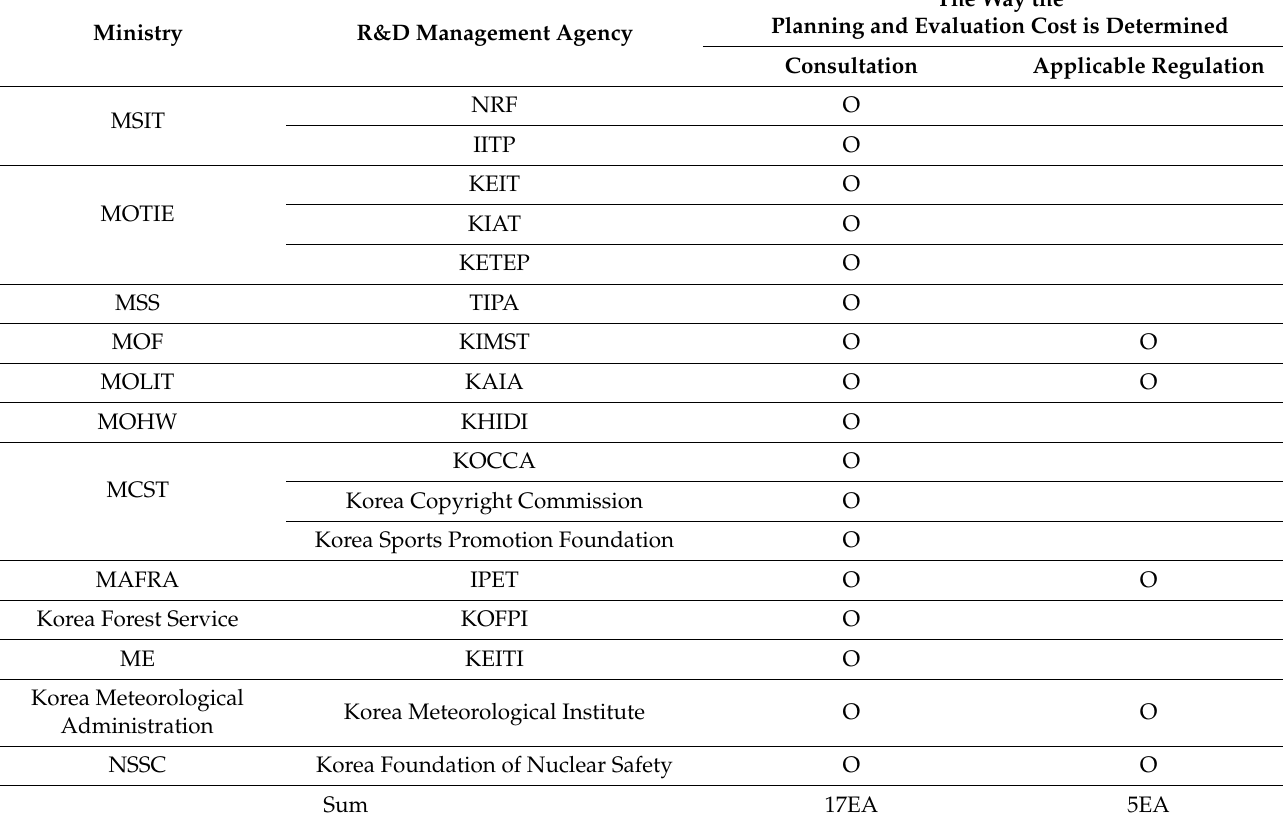
Table 5. Budgeting method for major R&D projects (2020).